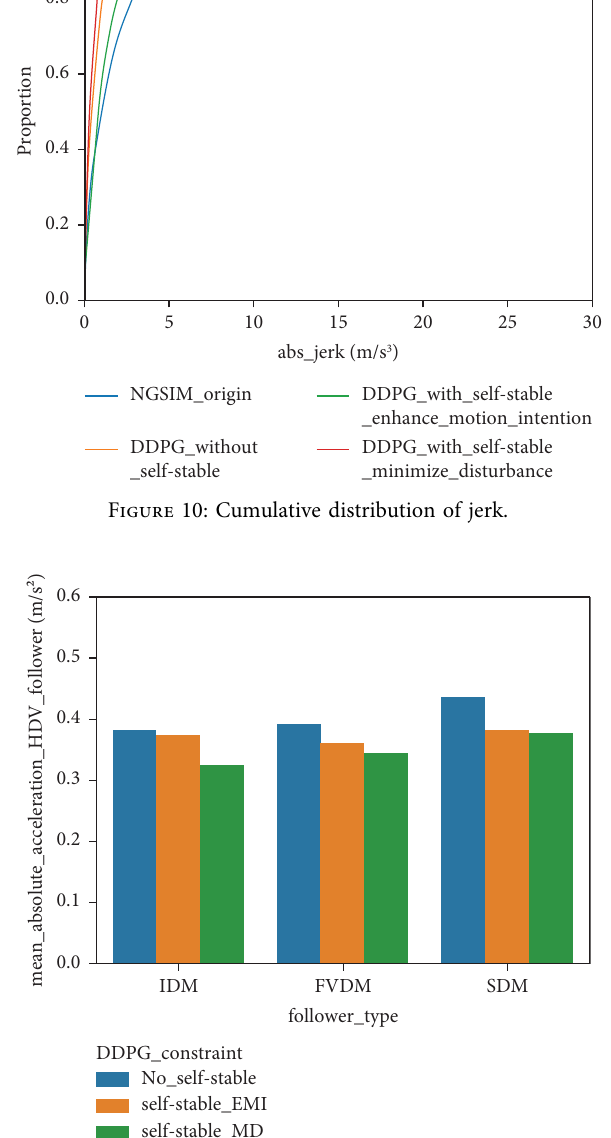
Figure 11: Mean absolute acceleration of HDV follower with diferent